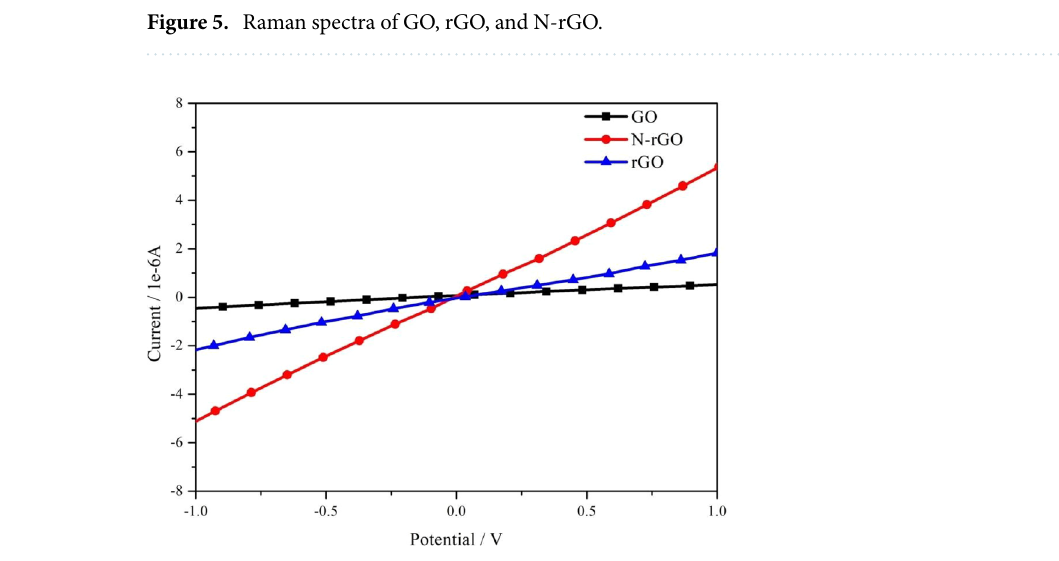
Figure 6. Current–voltage characteristics of GO, rGO, and